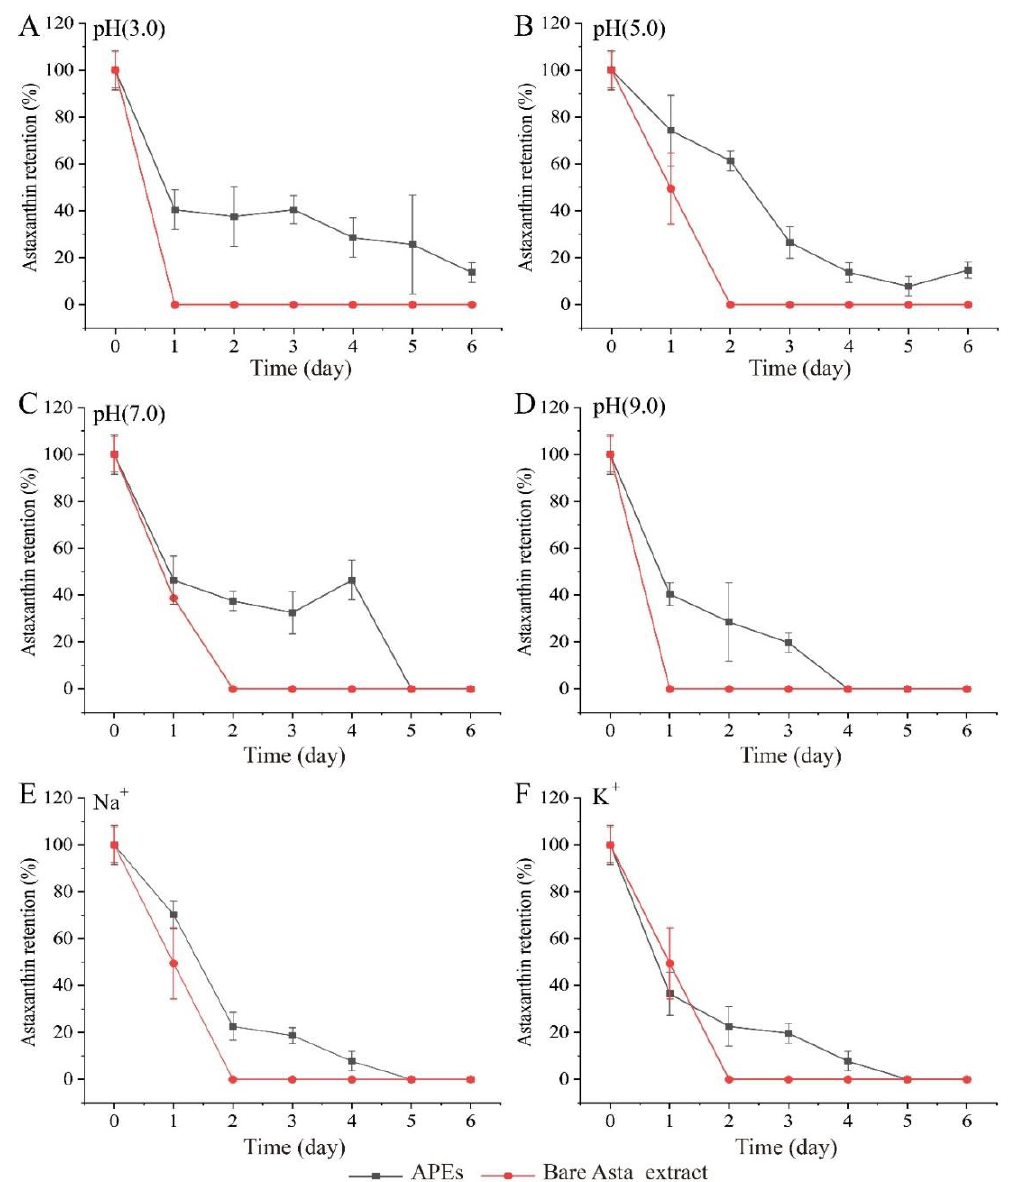
Figure 6. Effects of pH and metal ions on the total Asta retention of APEs during storage for six days under ambient temperature. The bare Asta extract was used as comparison. ( A ) Under pH 3.0 buffer, ( B ) under pH 5.0 buffer, ( C ) under pH 7.0 buffer, ( D ) under pH 9.0 buffer, ( E ) treated with 100 mM of Na + , and ( F ) treated with 100 mM of K + . Data were expressed as the mean ± standard deviation ( n = 3).